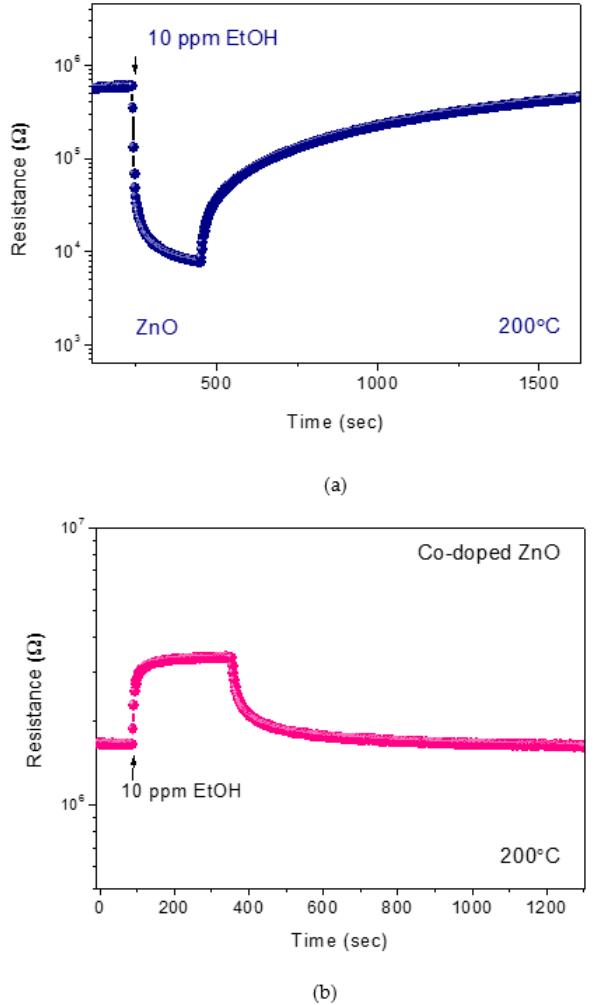
Figure 5. Response to 10 ppm of ethanol gas at different temperatures for ( a ) ZnO and ( b ) a Co-doped ZnO gas sensor.